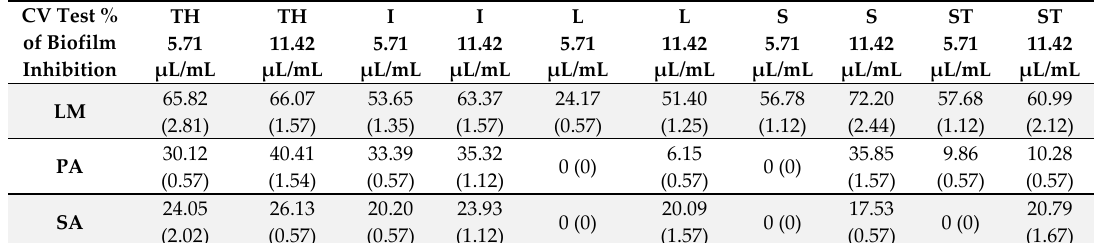
Table 1. Inhibitory action of the different types of monofloral honey on the formation of biofilm. Results are reported as percent of inhibition with respect to the control (which % was assumed = 0).